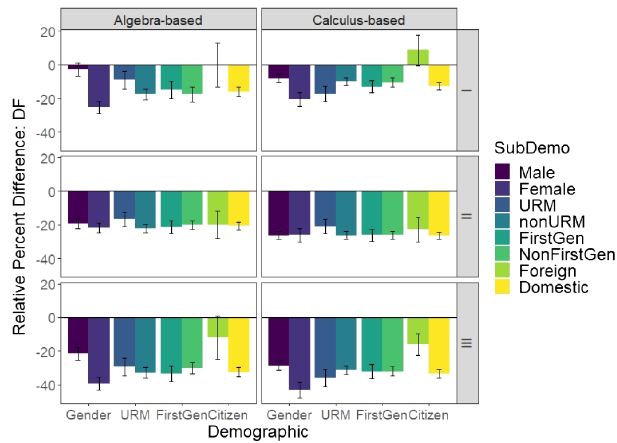
FIG. 4. Relative percent differences in D ’ s and F ’ s between model 0 and models I, II, or III, by demographic group and course. For example, if model I were used instead of model 0 in the algebra-based course, about 2% fewer males and about 25% fewer females would have received a D or F.